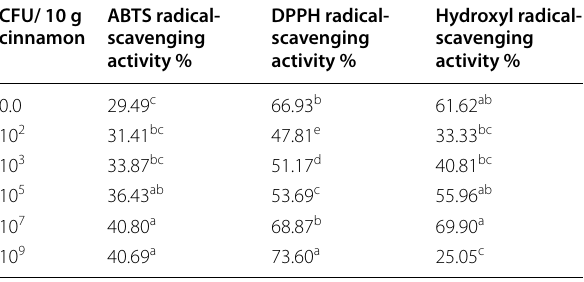
Where the data are the means of triplicate experiments; a, b, c, d values in the same column with different superscript letters are significantly different (P < 0.05). a value is the highest antioxidant activity and e value is the lowest antioxidant activity in the same column